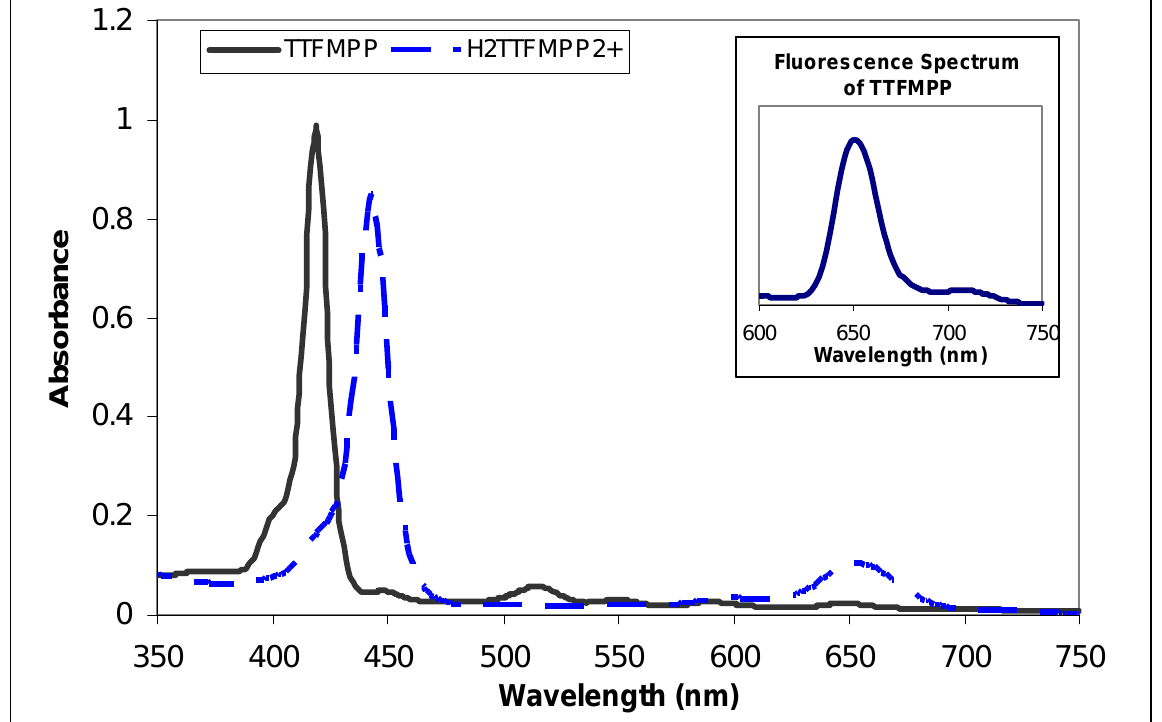
Figure 2 . Electronic Absorption spectrum of TTFMPP and the dication. Inset: Fluorescence spectrum of